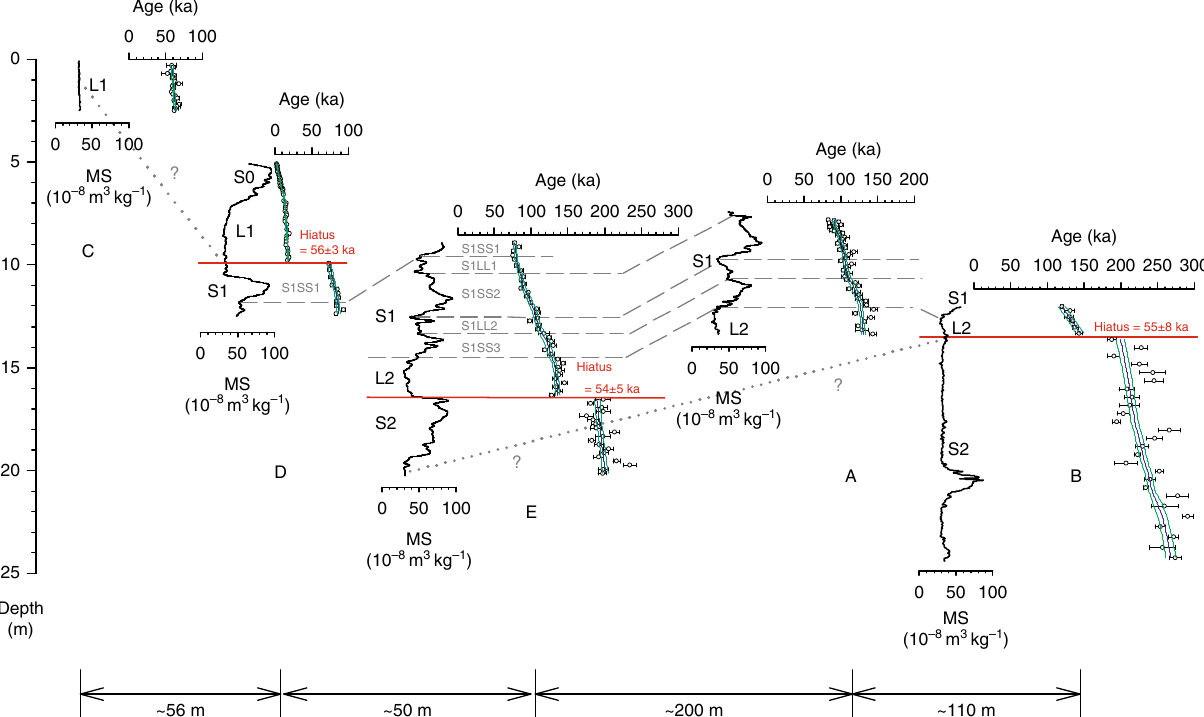
Fig. 2 Stratigraphic cross-section at Jingbian showing loess – palaeosol stratigraphy and luminescence age – depth relationship for 5 sections. Loess and palaeosol units are denoted with L and S, respectively. All sections start at the modern surface. Section C has the highest elevation and data from other sections are plotted relative to section C. Dashed lines indicate correlations between sections based on low- fi eld magnetic susceptibility and luminescence ages. Discontinuities are shown as horizontal red lines with the length of hiatus quoted. Where the correlation is solely based on luminescence ages and is less certain because of a discontinuity, a dotted line with question mark is used. Ages are plotted with 1 s.d. errors and Bayesian age – depth models are shown as solid blue (weighted mean age) and green (1 s.d. uncertainty envelope) lines. Detailed luminescence age – depth pro fi les for the individual